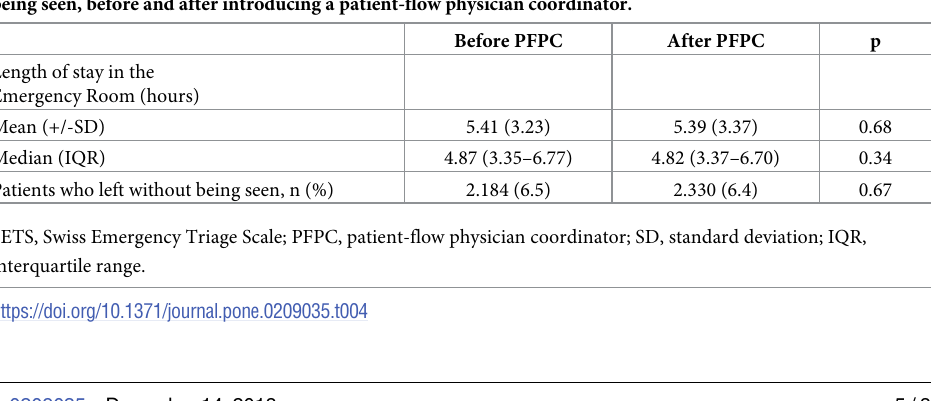
SETS, Swiss Emergency Triage Scale; PFPC, patient-flow physician coordinator; SD, standard deviation; IQR, interquartile range.